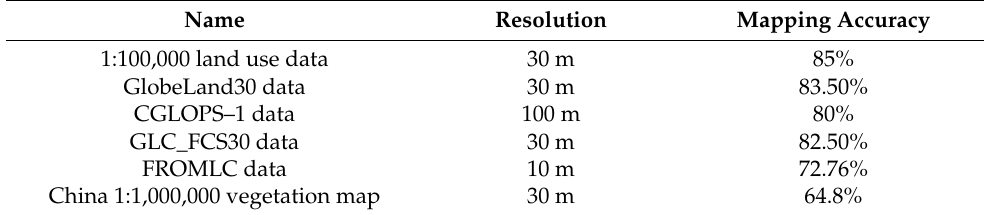
Table 1. Detailed information of the six non-homogenous land use